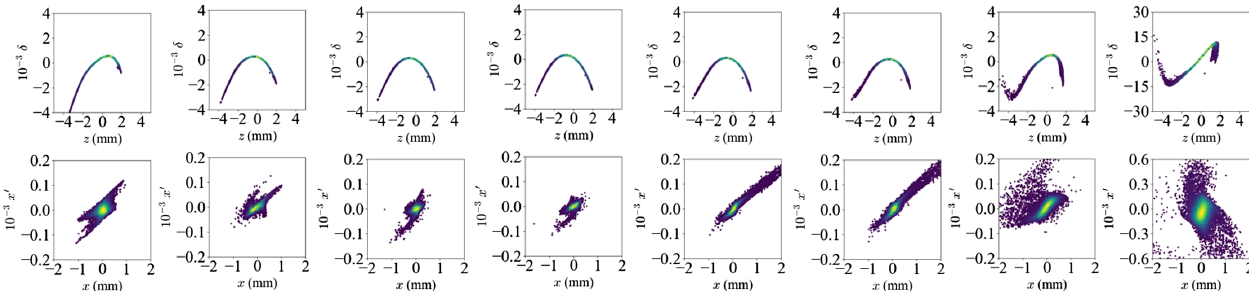
2500.FIG. 26. Simulated x − x 0 and z − δ distributions after each of the 8 LINAC passes for CBETA 4-turn with no CSR. Note that the rightmost plots for the 8th pass have different vertical